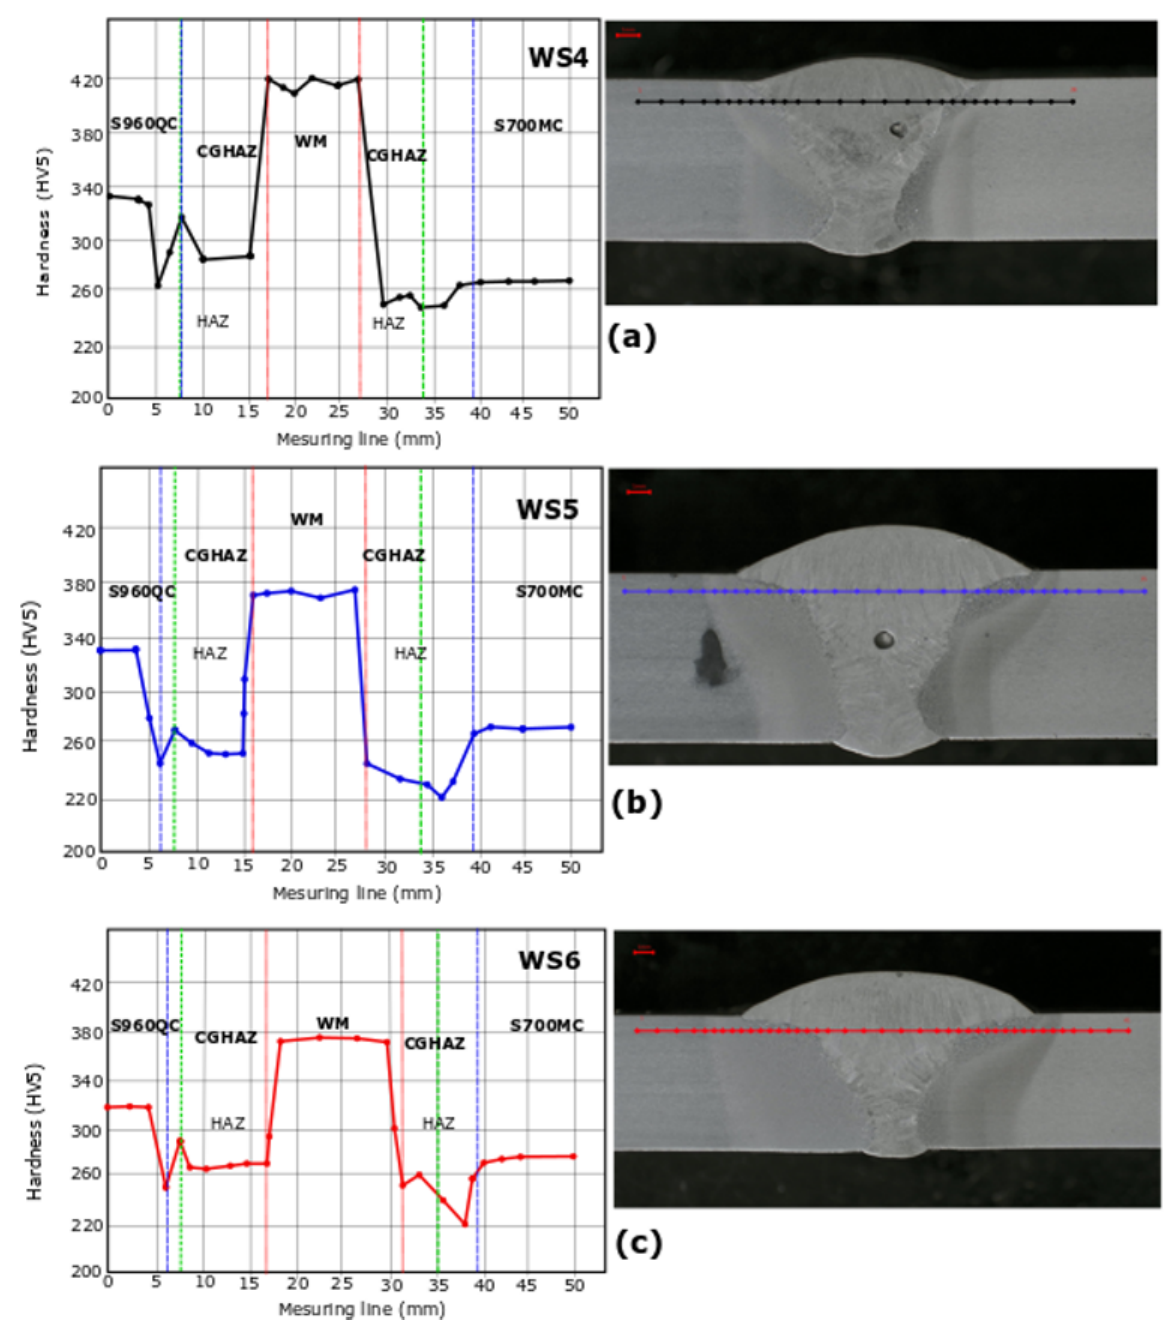
Figure 3: Vickers- hardness profile using overmatched filler wire in the weld joint: (a) hardness profile of weld sample using 7 kJ/cm of heat input, (b) hardness profile of weld sample using 10 kJ/cm of heat input, (c) hardness profile of weld sample using 15 kJ/cm of heat input.